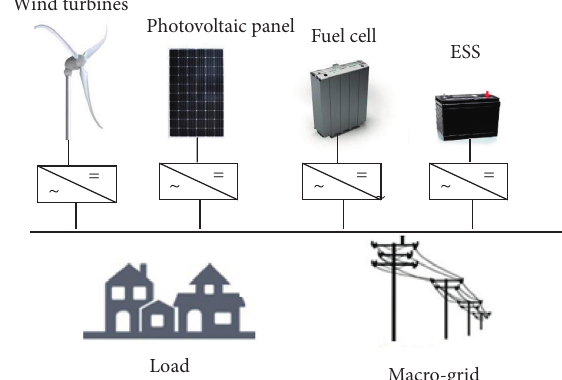
Figure 1: Proposed structure and components in the considered